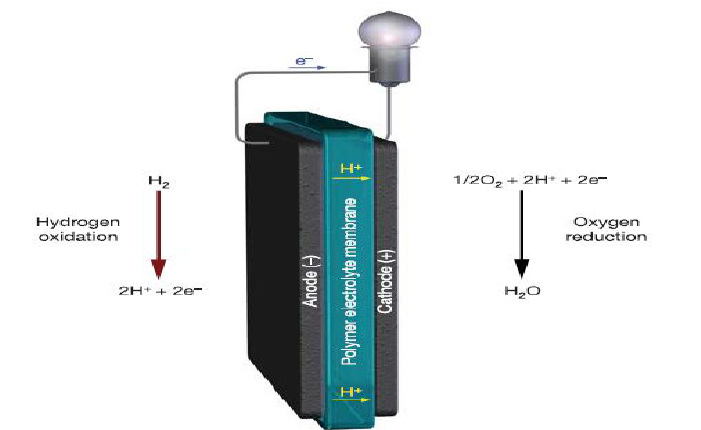
Figure 1. The schematic process for power production in PEMFC. (Reprinted from Reference 25 with